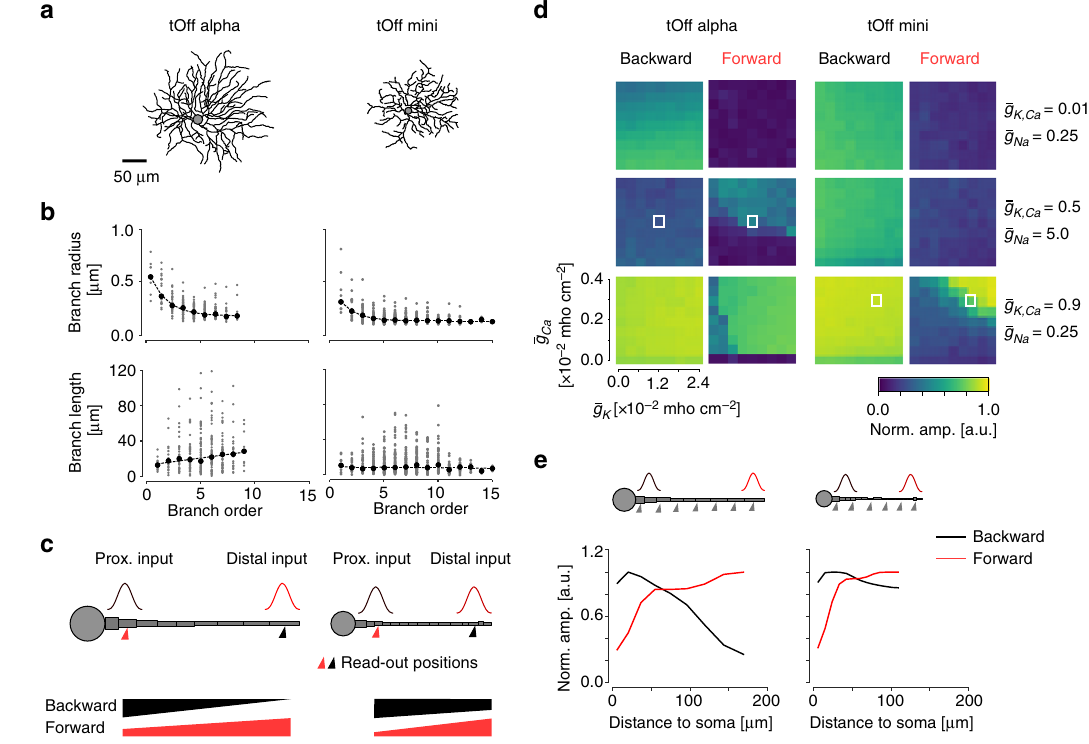
Fig. 7 Simulation of dendritic signal propagation in tOff alpha and tOff mini RGCs. a Reconstructed cell morphologies of tOff alpha and tOff mini RGC (same cells as in Figs. 3, 4). b Dendrite radius (top) and segment length as functions of branch order (data from http://museum.eyewire.org; n = 2 for tOff alpha (4ow); n = 3 for tOff mini (4i)). c Illustration of the ball-and-stick models used for simulations in d , e . Simulated inputs at proximal (25 µ m to soma) and distal (85% of the total dendrite length to soma) positions indicated as red and black Gaussians, respectively. Respective read-out positions for d are indicated below the dendrite. The thickness change of the bars (bottom) corresponds to the decay of forward (red) and backward (black) signal propagation expected from our experimental data. d Heat maps showing the signal amplitude at the two read-out positions indicated in c , normalised to the amplitude at the respective input position as a function of ion channel density combinations. White boxes indicate channel combinations that are consistent with our experimental results. e Normalised signal amplitude at read-out positions along the dendrite as a function of dendritic distance for the channel combinations indicated by boxes in d . Generic voltage-gated ( (cid:1) g , (cid:1) g , (cid:1) g ) and Ca 2 + activated ( (cid:1) g ) conductances were modelled after Ca K Na K ; Ca Fohlmeister and Miller (refs. 67 ). For details, see